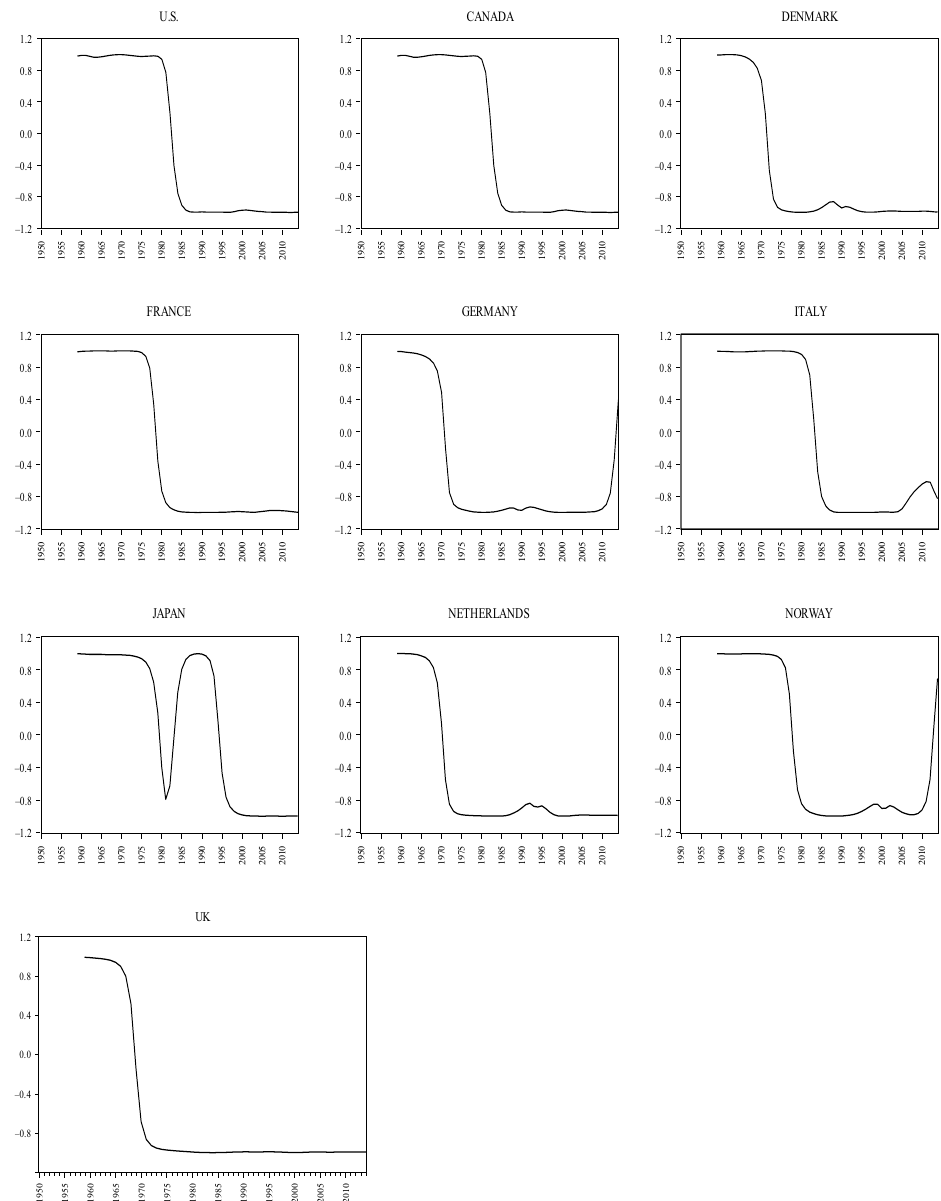
Fig. 4. Rolling correlation analysis between labor productivity and employment 1950–2014 Source: authors’ calculation using data from The Conference Board Databases – Total Economy Da- tabase and International Labor Comparison program 2016, U.S. Bureau of Labor Statistics, Penn World Table